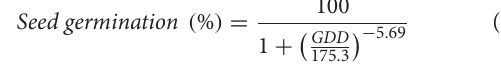
detected near a livestock feed distribution industry located near Nahalal (circled in white in Figure 1D